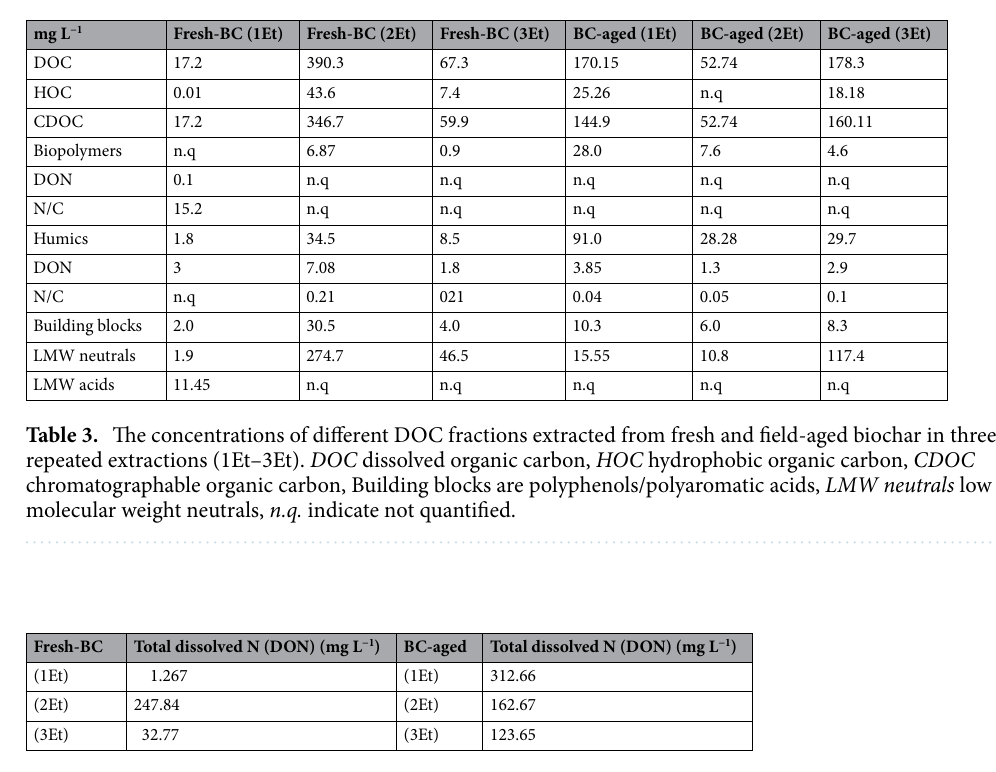
Table 4. The concentration of dissolved organic nitrogen in fresh and field aged biochar.